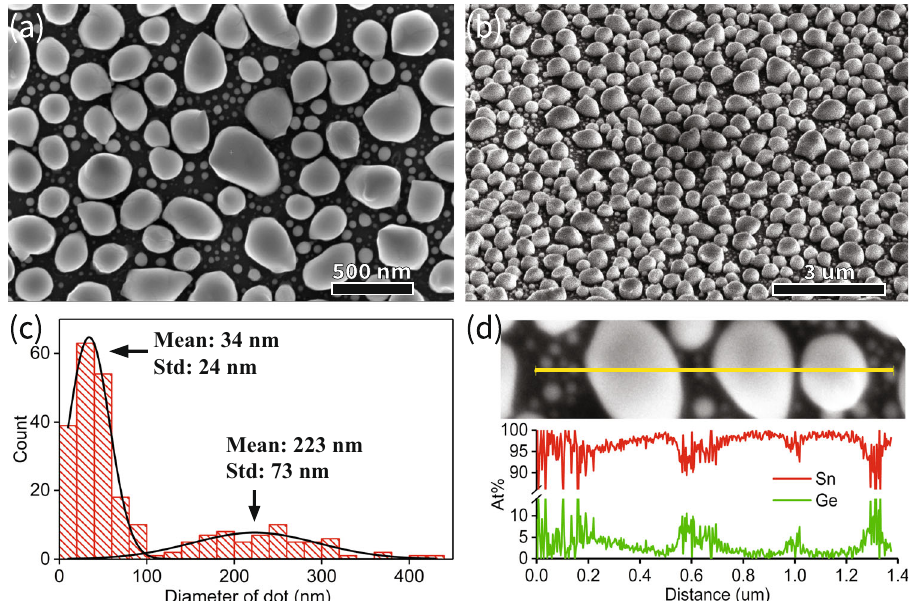
Fig. 1 SEM and EDS analysis of a SnGe sample annealed at 350 °C. a Top-view SEM image of the SnGe sample. b SEM image of the SnGe sample tilted at 52 ∘ . c Histogram and two-peak bimodal Gaussian fi t of the diameters of the dots shown in a . d EDS line scan showing at.% of Sn (red) and Ge